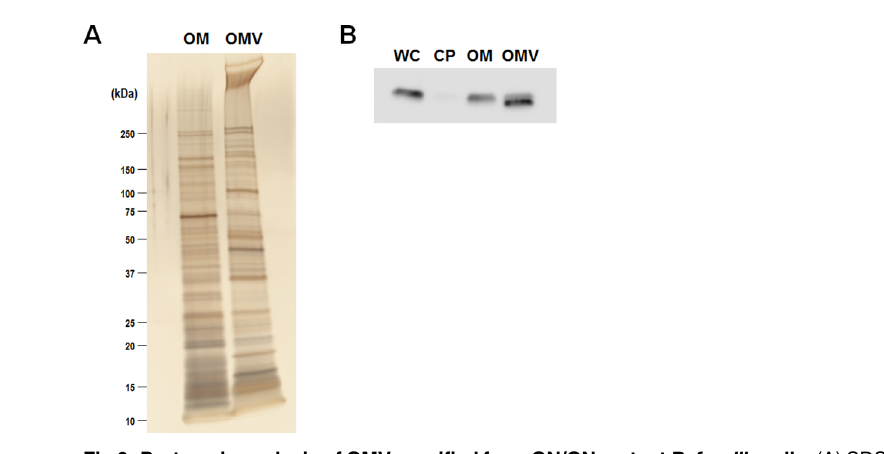
Fig 6. Proteomic analysis of OMVs purified from ON/ON mutant B . fragilis cells. (A) SDS-PAGE patterns of outer membrane (OM) and OMV fractions. (B) Localization of FLAGtag-fused BF3397 protein. One micrograms of the each purified fraction was separated by SDS-PAGE and BF3397 localization was determined by Western blotting with anti-FLAGtaq antibody. WC, whole cell; CP, cytoplasmic fraction; OM, outer membrane fraction; and OMV, outer membrane vesicle